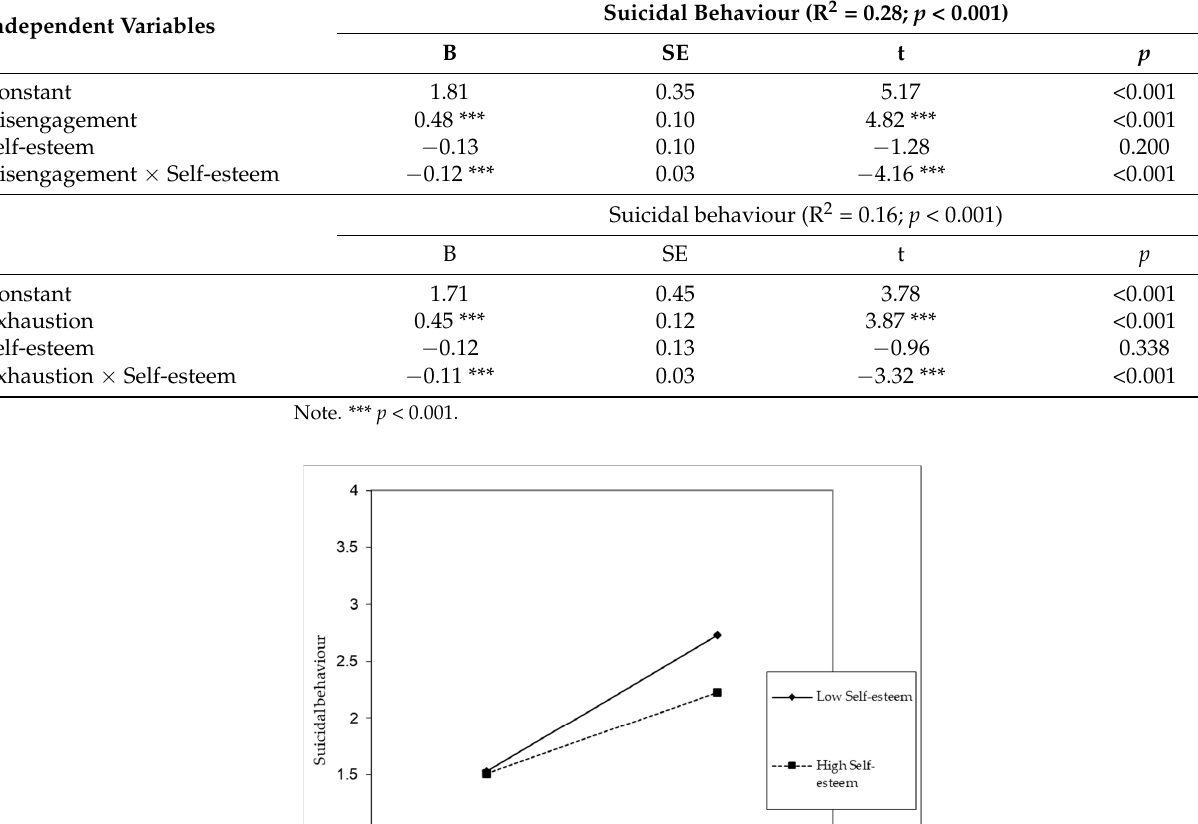
Table 7. Results of the moderator effect test (H3).